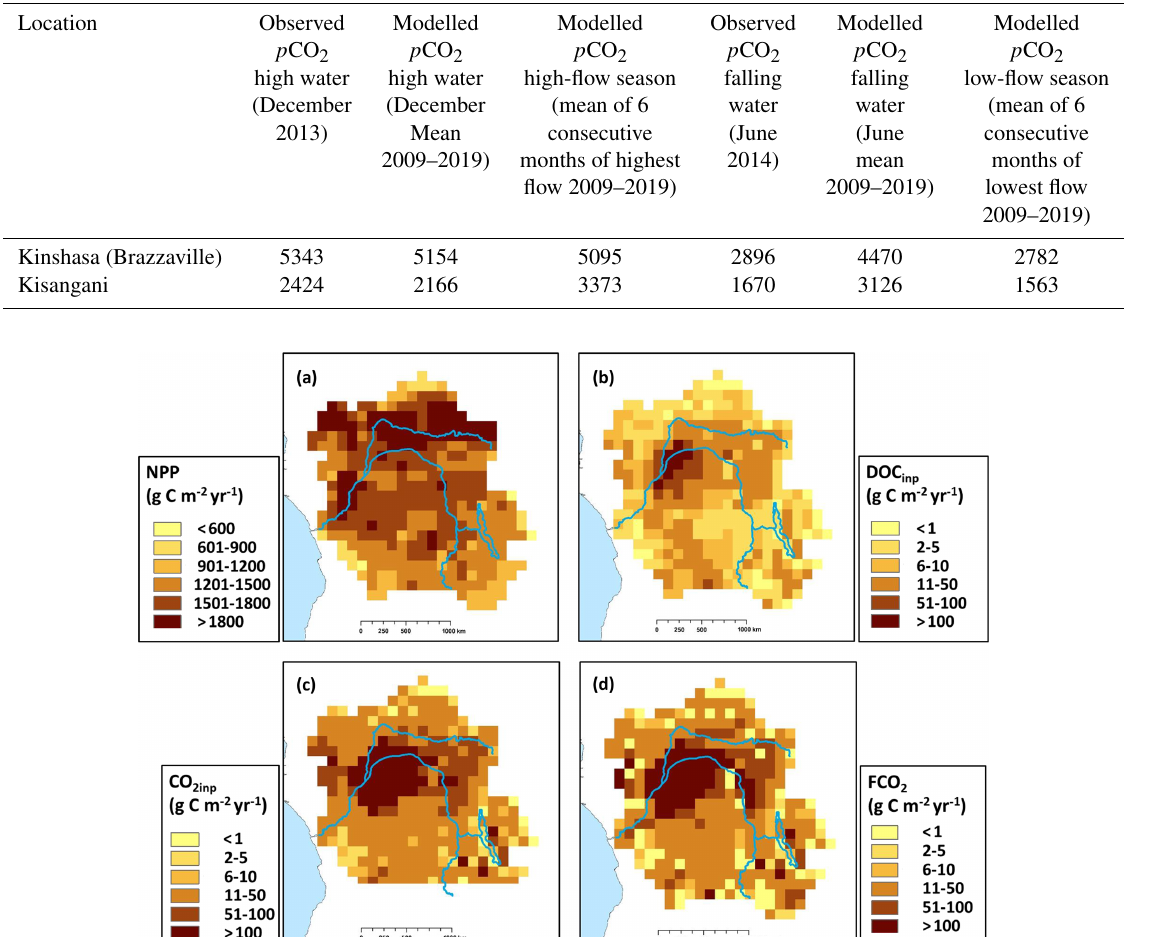
Table 3. Observed (Borges et al., 2019) and modelled p CO 2 (in ppm) at Kinshasa (Brazzaville) and Kisangani on the Congo River at various water levels.